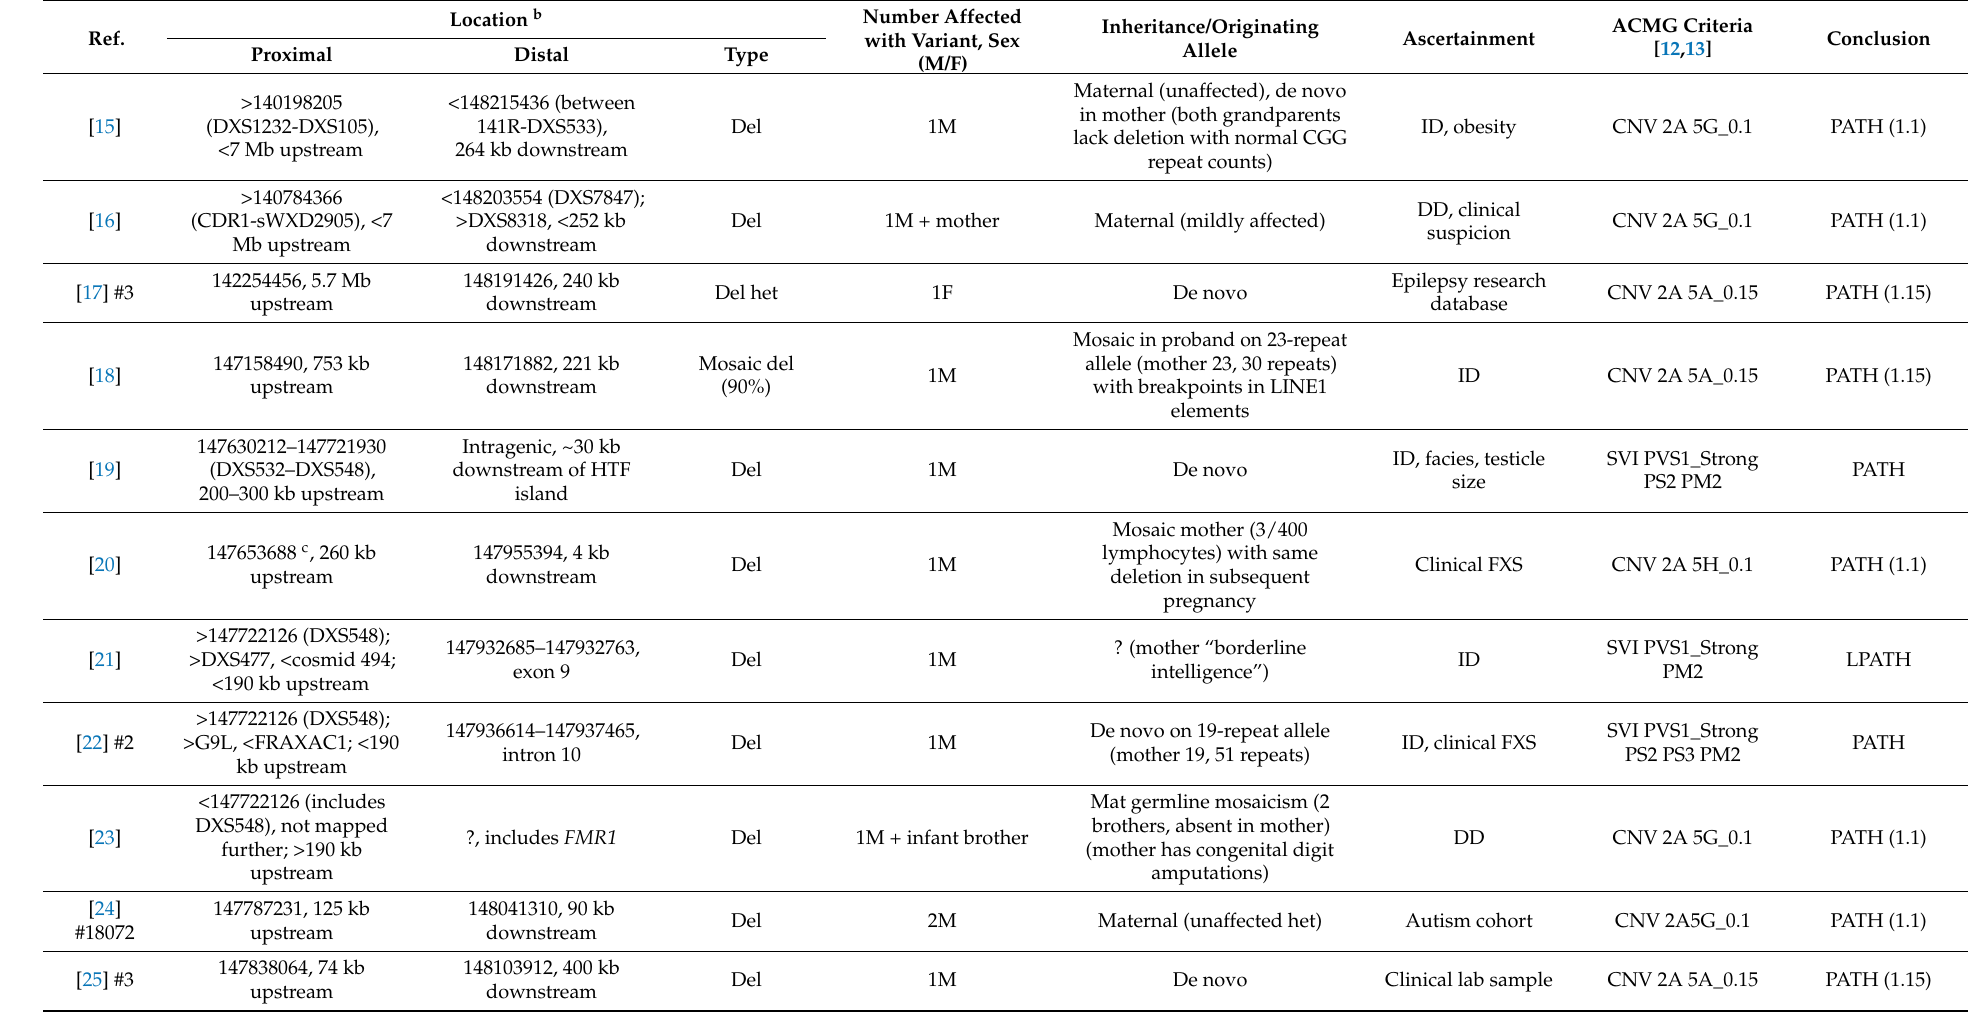
Table 1. FMR1 CNVs reported in the absence of CGG repeat expansions a